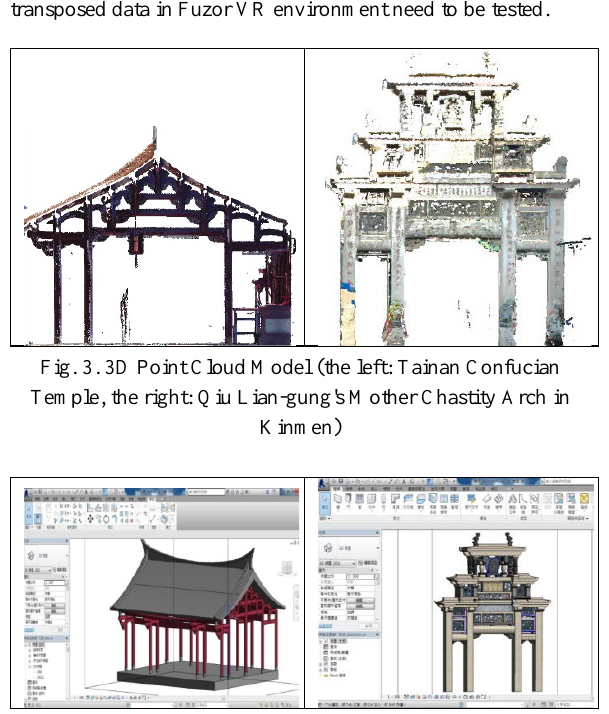
Fig. 4. Autodesk Revit Establishment Results (the left: Tainan Confucian Temple, the right: Qiu Lian-gung's Mother Chastity Arch in Kinmen)